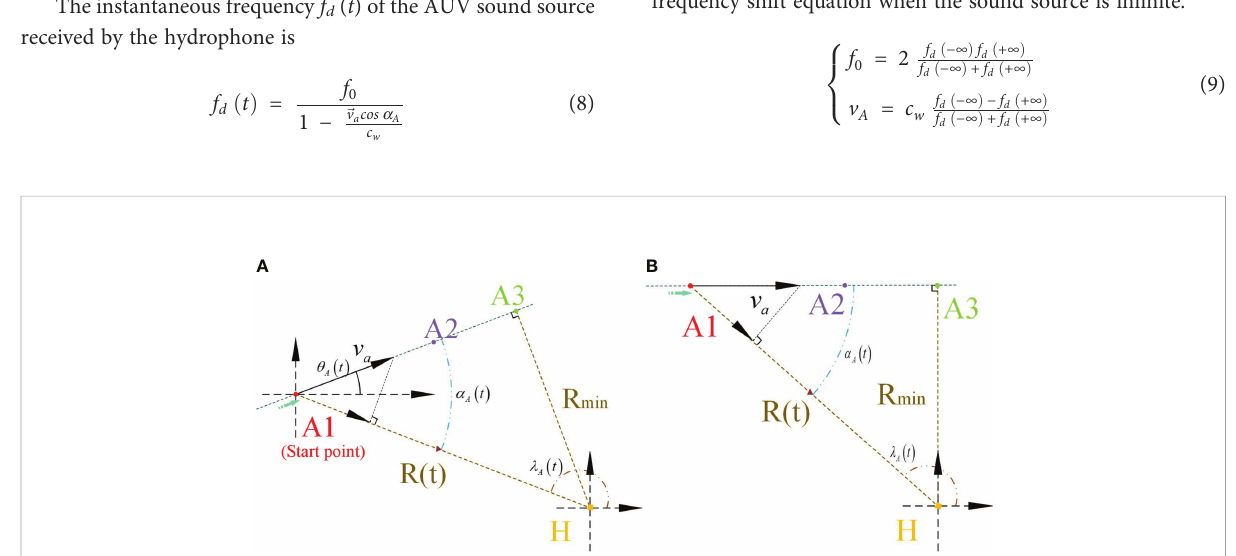
FIGURE 4 Top view of an AUV ’ s radiated noise propagation and hydrophone nodes. (A) AUV radiated noise propagation and hydrophone node in Fixed- frame. (B) AUV radiated noise propagation and hydrophone node in AUV velocity